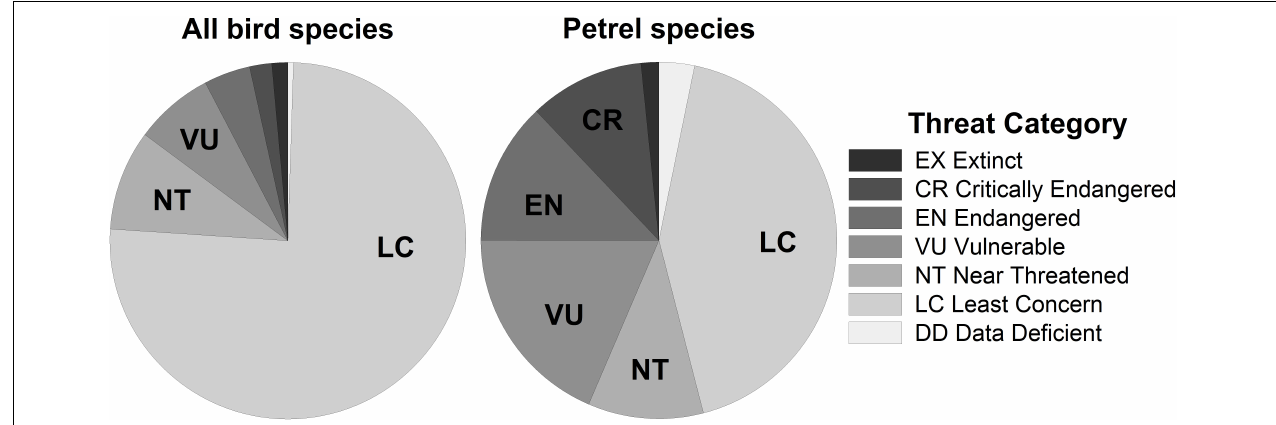
FIGURE 1 | The percentage of species categorized by IUCN threat category for birds (left; n = 11,126 species) and for petrels (right; Procellariidae, Oceanitidae, and Hydrobatidae families; n = 124 species). Data from the IUCN Red List (BirdLife International, 2018a).